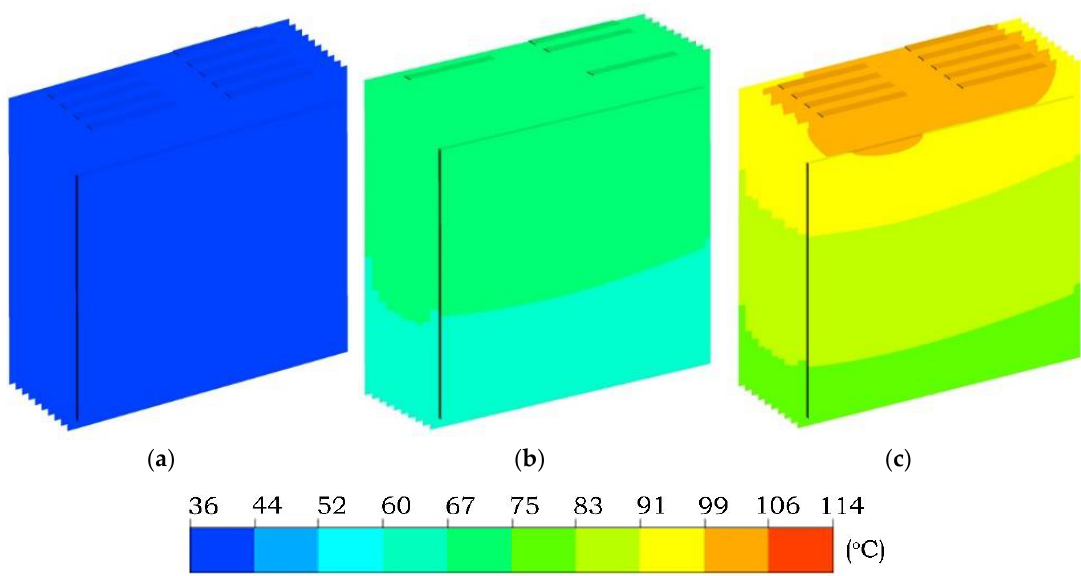
Figure 5. Temperature distribution of the battery module after discharging at ( a ) 1C, ( b ) 3C, and ( c ) 5C.